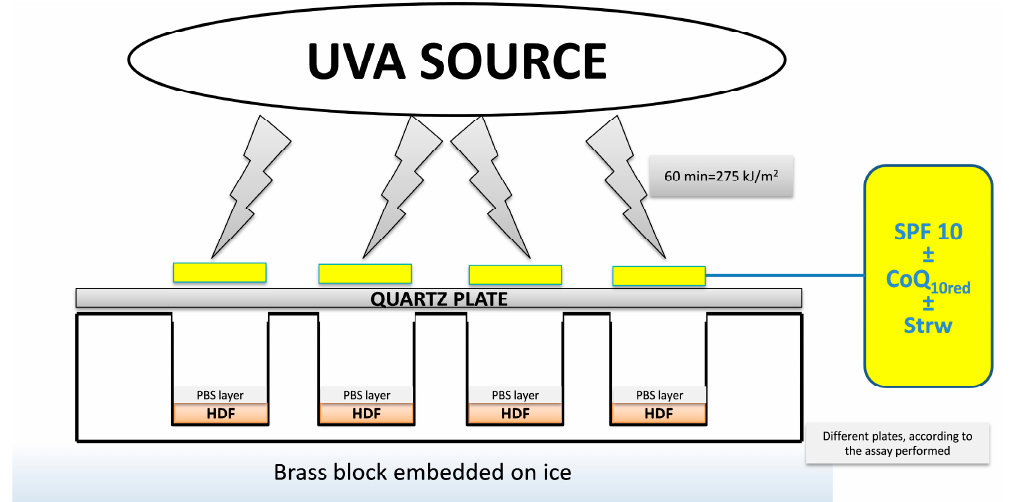
Figure 1. Schematic representation of the experimental setup used to apply the different formulations to the cell cultures. UVA, Ultraviolet A; PBS, phosphate buffered saline; HDF, Human Dermal Fibroblast; SPF 10, sun protection factor 10; CoQ 10red , reduced coenzyme Q 10 and Strw, strawberry.